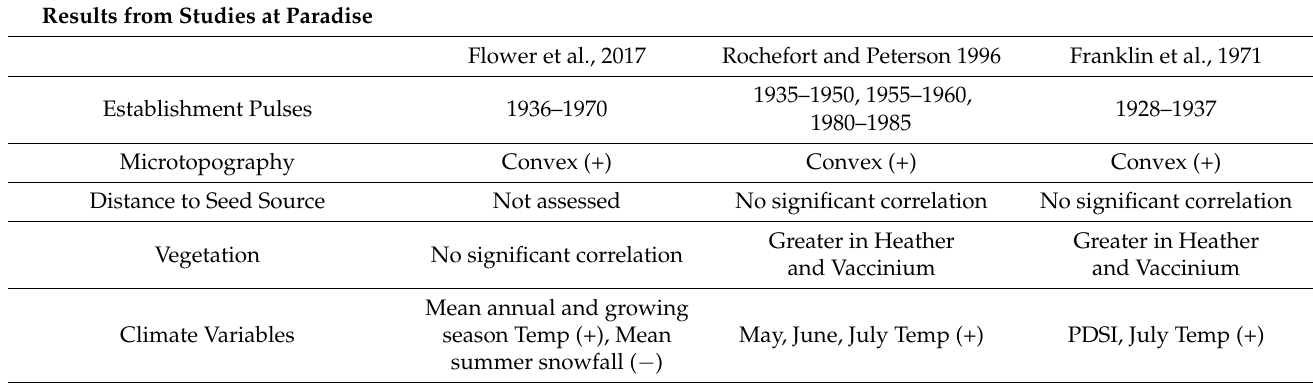
Table 9. Reported relationships between establishment and climatic and spatial variables in three previously published studies conducted at Paradise at Mt.